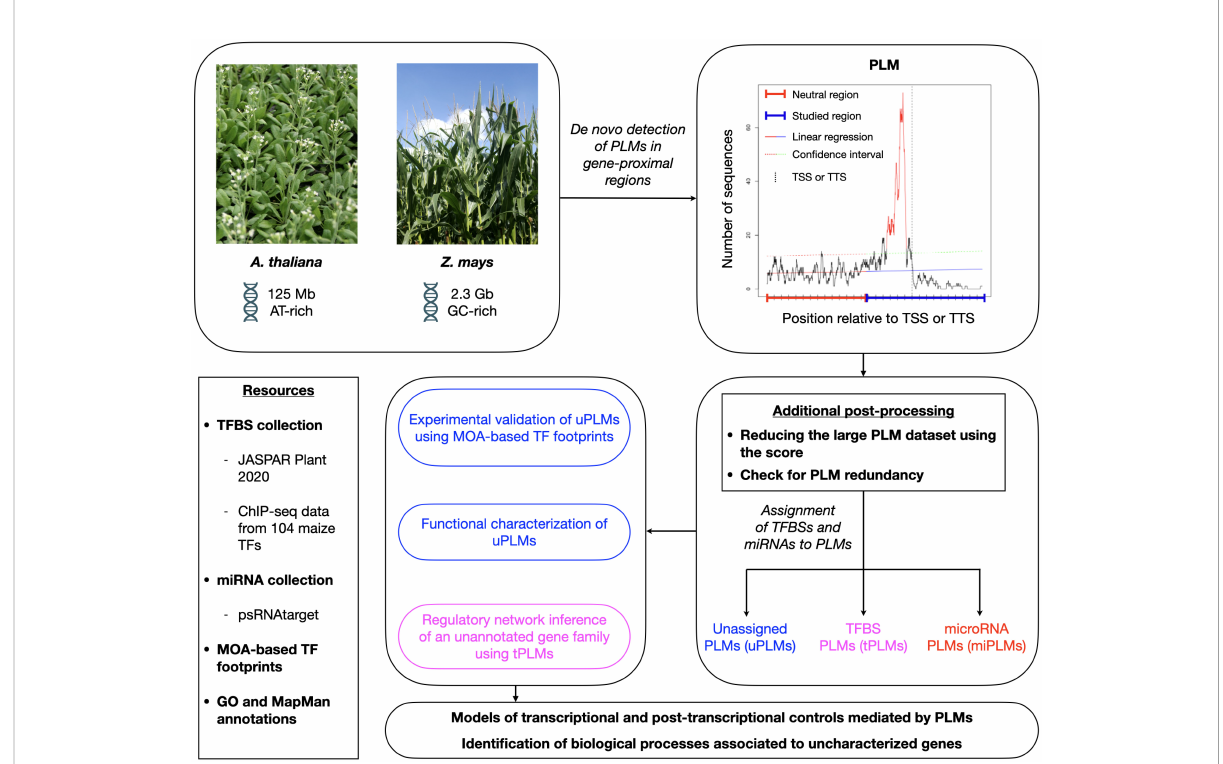
FIGURE 1 Schematic overview of the work fl ow used in this study for de novo and genome-wide quanti fi cation, characterization, and exploitation of PLMs in gene-proximal regions of A. thaliana and Z. mays . We fi rst detected PLMs in the 5 ’ - and 3 ’ - proximal regions of genes from both plant species. Next, we selected the PLMs according to their score, checked for PLM redundancy and determined whether some of the detected PLMs might be TFBSs (referred to as tPLMs) or targeted by miRNAs (referred to as miPLMs) using distinct resources of TFBSs [JASPAR Plant 2020 (Fornes et al., 2019) and top 1% k-mers from ChIP-seq data of 104 maize TFs (Tu et al., 2020)] and miRNA binding sites [psRNATarget (Dai et al., 2018)]. Unassigned PLMs (referred to as uPLMs)-containing gene sets were functionally characterized with GO and MapMan enrichments relative to the genome. Moreover, we showed that some 5 ’ -uPLMs were supported by MOA-based TF footprints data (Savadel et al., 2021) of Z. mays. Using 5 ’ -tPLMs, we fi nally inferred the regulatory network of a poorly characterized maize-speci fi c gene family. Collectively, our results provide functional inside into the regulatory role of PLMs and highlight biological processes associated to uncharacterized